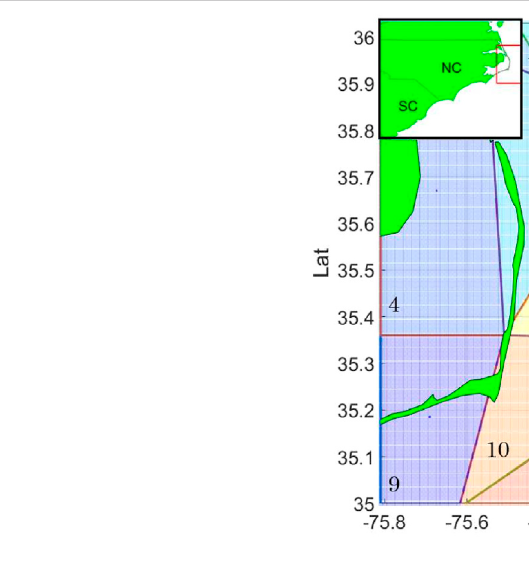
Frontiers in Robotics and AI |